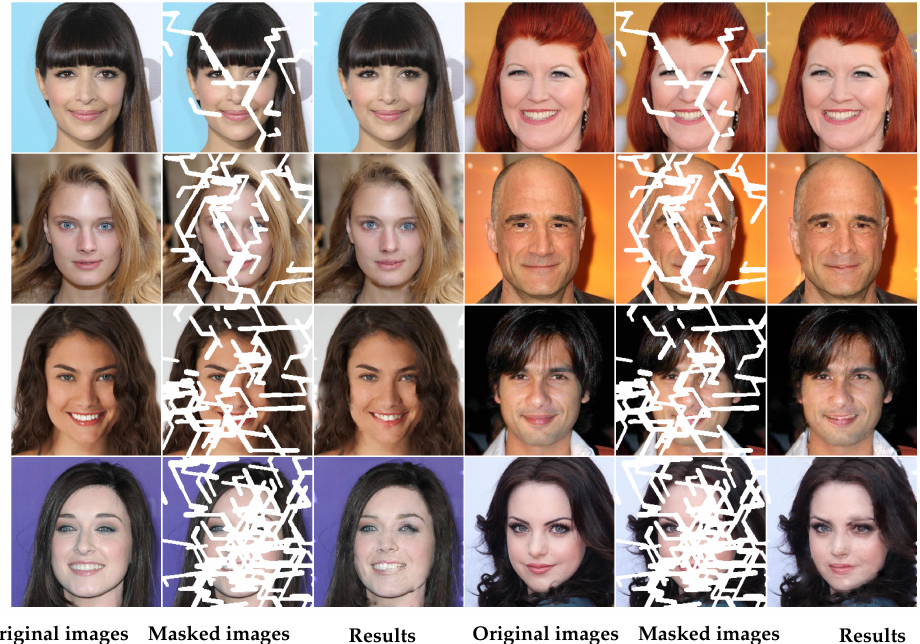
Figure 11. Inpainting results of masked images with different proportion free-form brush. The first to fourth rows are 10–20%, 20–30%, 30–40% and 40–50% random free-form brush masks,